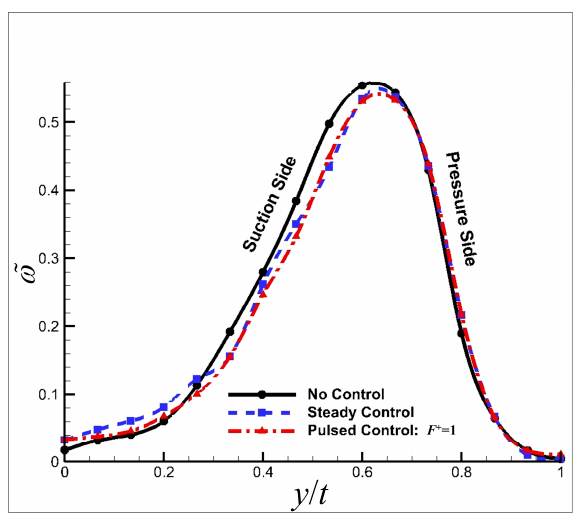
Figure 25. Total pressure loss coefficient distribution at the outlet of the cascade (experimental results).